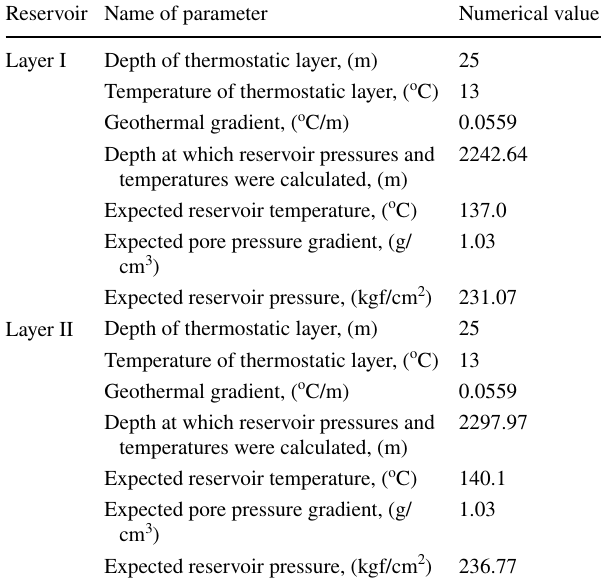
Table 9 Expected values of reservoir pressures and temperatures